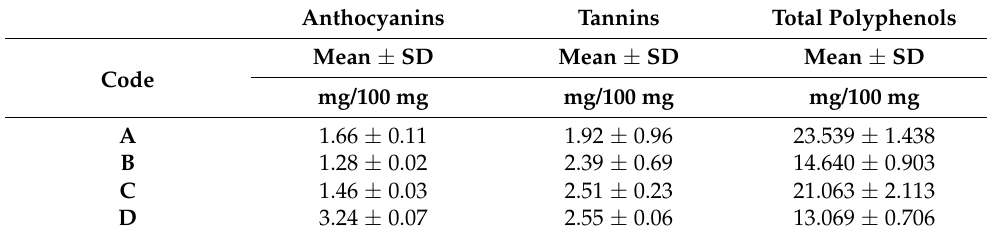
Table 2. Total content of anthocyanins, tannins, and total polyphenols as determined by spectrophotometry.